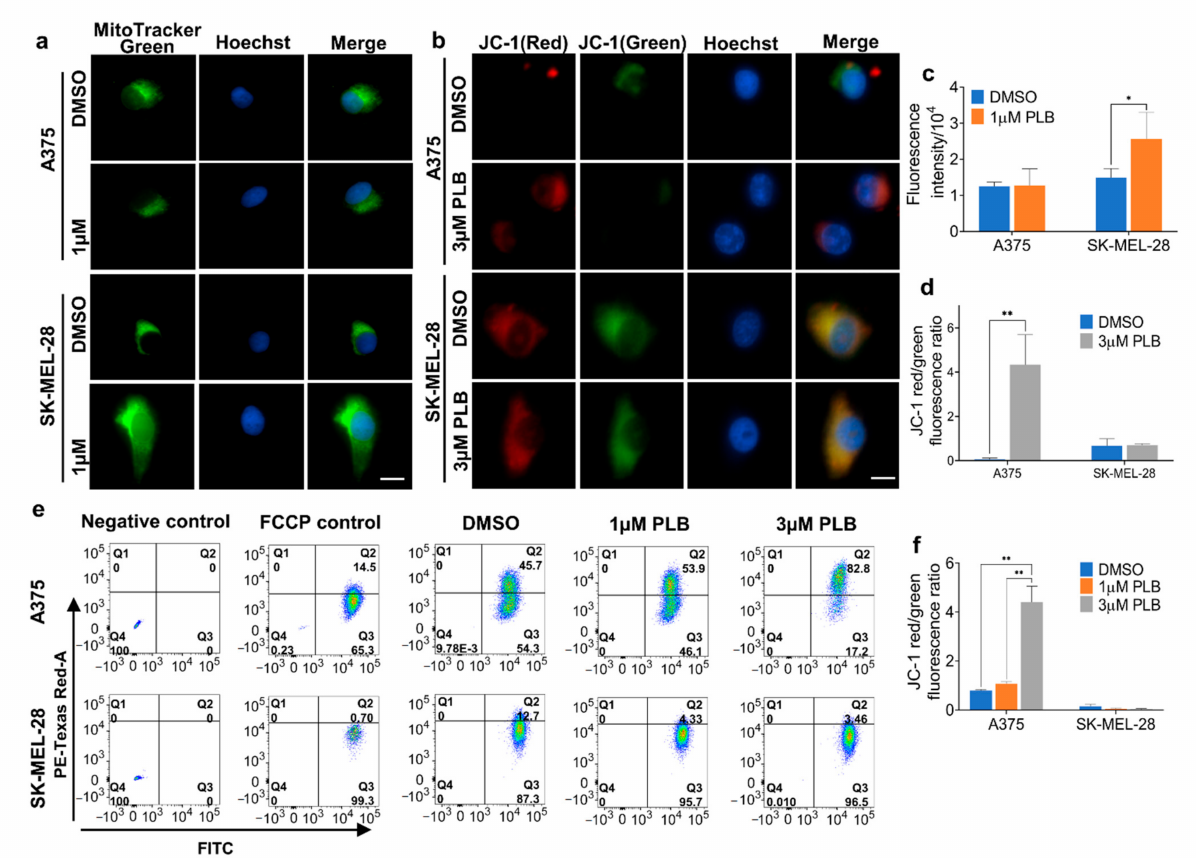
Figure 7. Mitochondrial mass and membrane potential. ( a ) Melanoma cells were seeded in the 4-well chambers with DMSO and 1 µ M PLB, treated, and stained by 50 nM Mitotracker Green and 2 µ g/mL Hoechst dye. The figure set displays the fluorescence images under a 60X microscope. Scale bar = 10 µ m. ( b ) Melanoma cells were seeded in the 4-well chambers with DMSO and 3 µ M PLB, treated, and stained by 2 µ M JC-1 and 2 µ g/mL Hoechst dye. The figure set displays the fluorescence images under a 60X microscope. Scale bar = 10 µ m. ( c ) The intensity of Mitotracker Green. ( d ) The ratio of red to green intensity of JC-1. ( e ) Melanoma cells with DMSO and 1 and 3 µ M PLB treatment were stained with 2 µ M JC-1 and 2 µ g/mL Hoechst dye and detected by flow cytometry. No staining and FCCP-treated groups were negative and positive control. ( f ) The ratio of cells with red fluorescence to cells with green fluorescence. Results are expressed as mean ± SD. * p < 0.05, ** p <